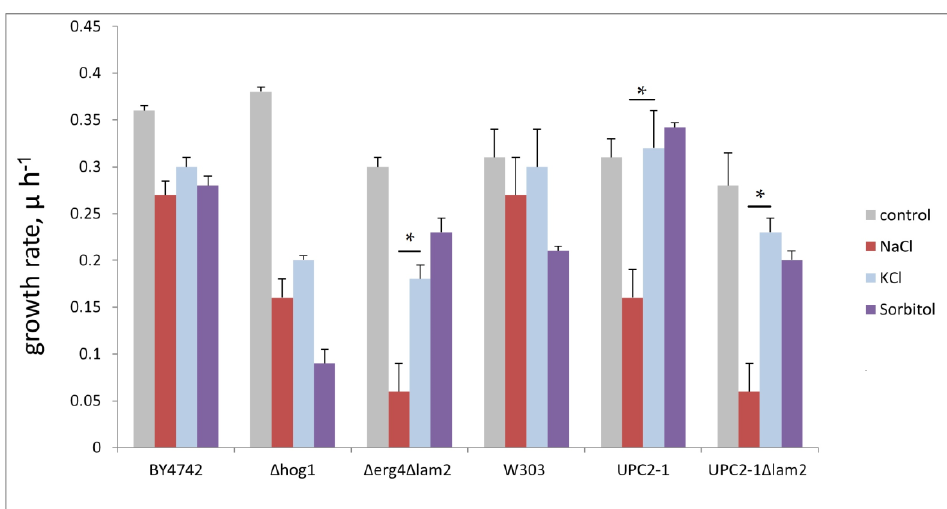
Figure 4. S. cerevisiae mutants with elevated PM sterol ( ∆ erg4 ∆ lam2, upc2-1 and upc2-1 ∆ lam2 ) are more sensitive to hyperosmotic stress induced by 0.6 M NaCl, but not 0.6 M KCl or 1.2 M sorbitol. Y -axis: growth rate, division time equals 0.434/ µ . * p < 0.05, Two-sample t -test for independent samples.